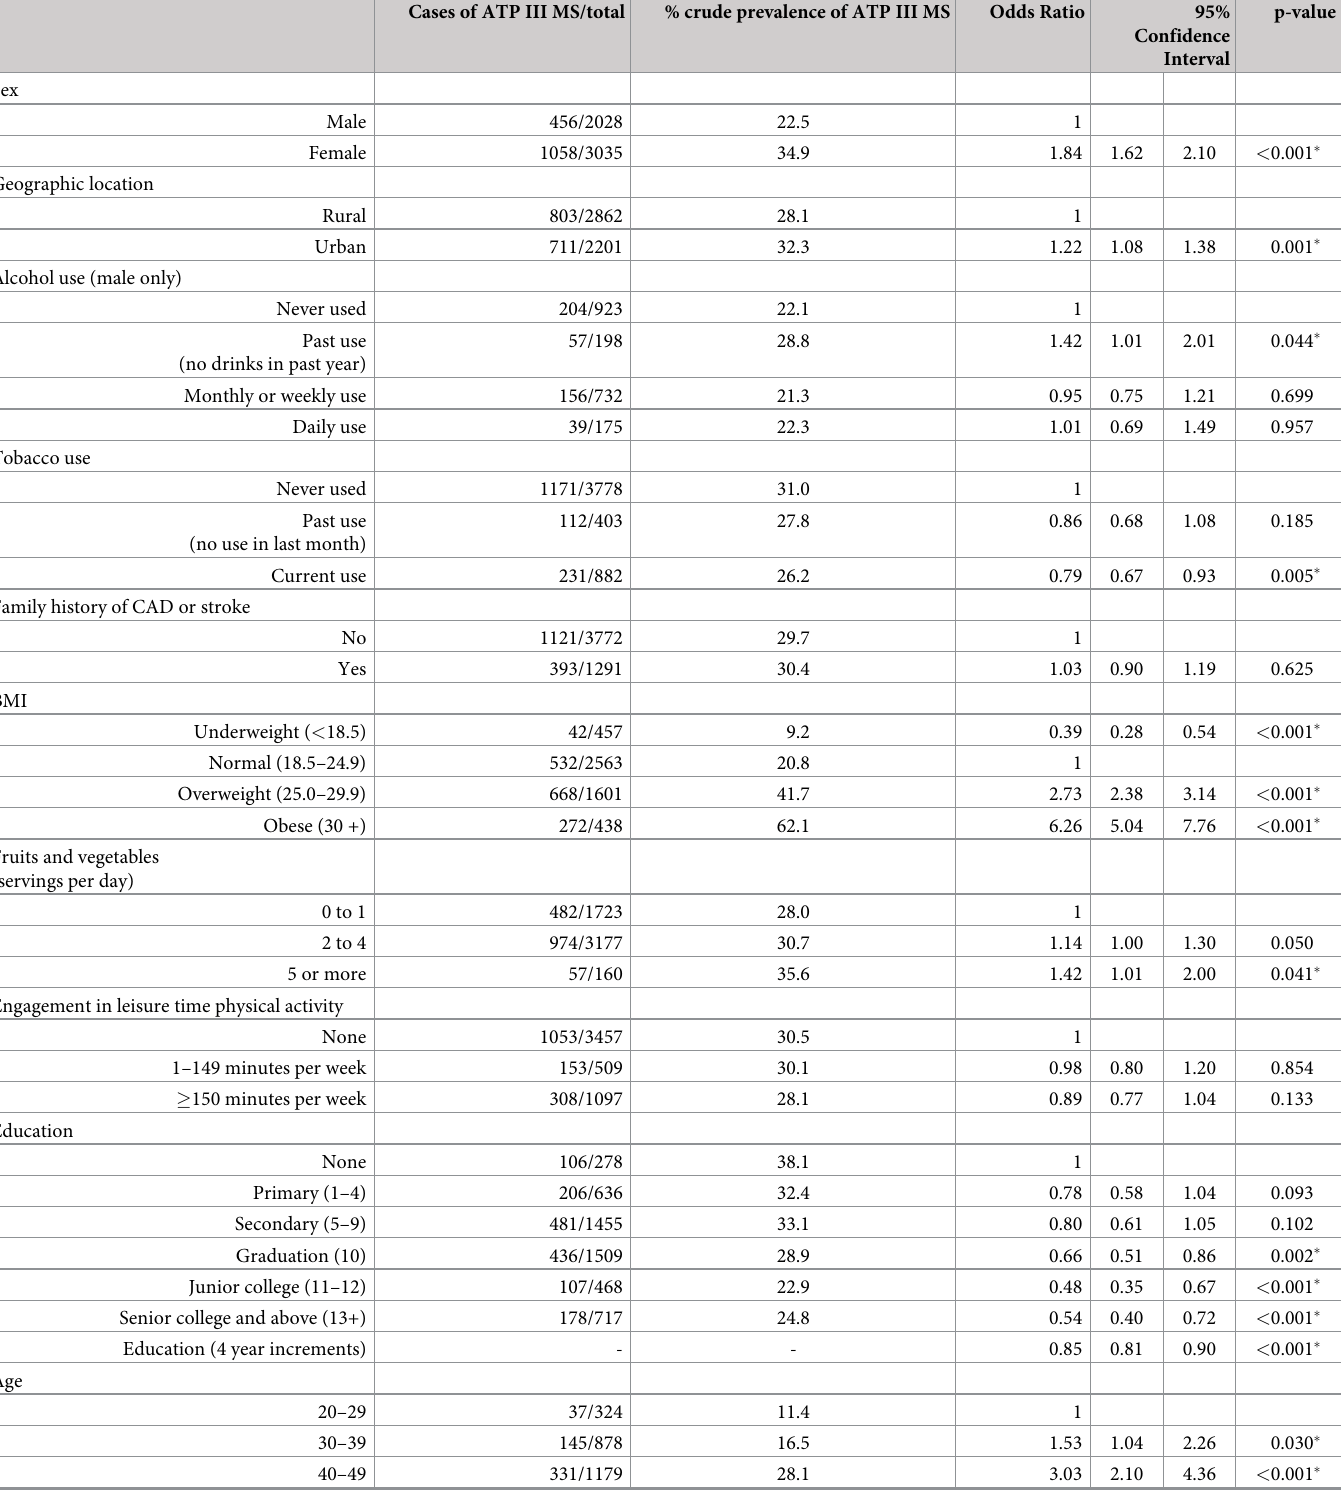
Table 5. Risk factors associated with ATP III metabolic syndrome in a univariate logistic regression